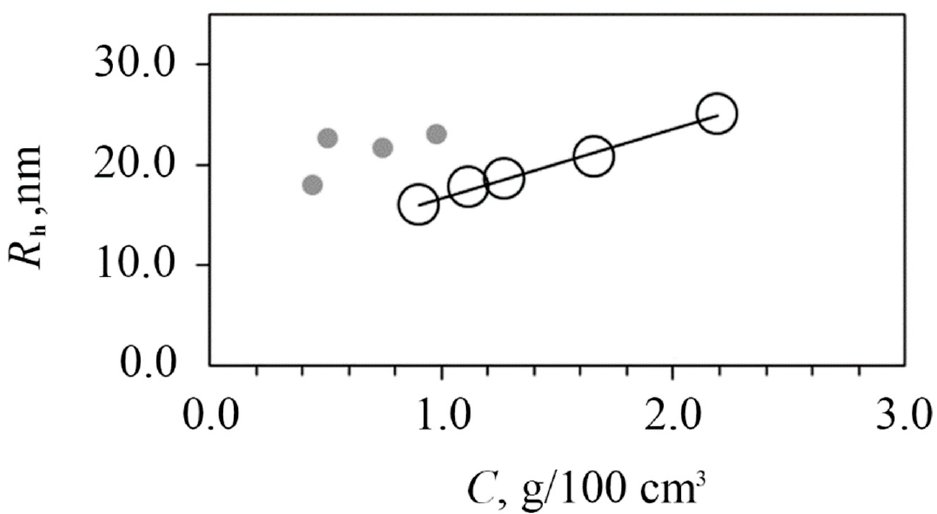
Figure 8. Hydrodynamic radii of dissolved species vs. concentration in 0.15 M NaCl for freshly pre- pared PAAg solutions (open symbols) and solutions aged after a year (grey symbols).